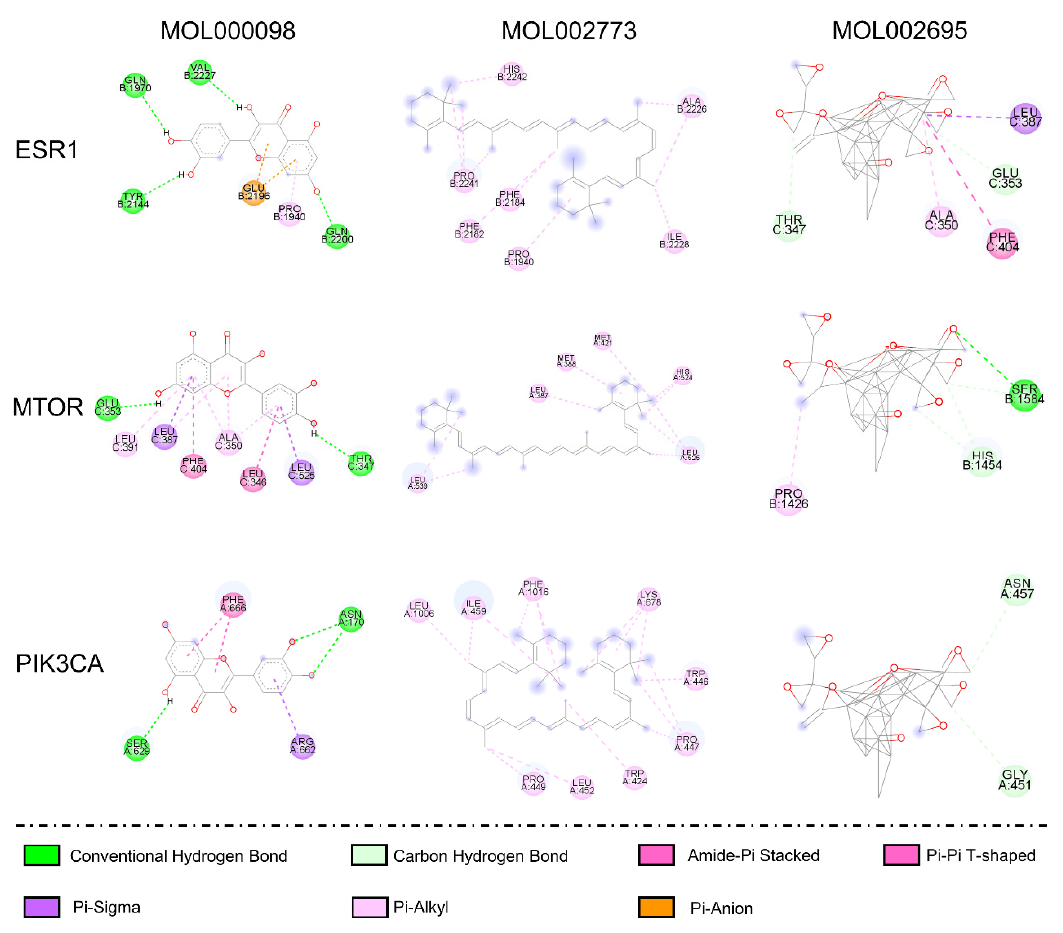
Figure 10. The 2D schematic diagram of molecular dockings of key components and critical targets.